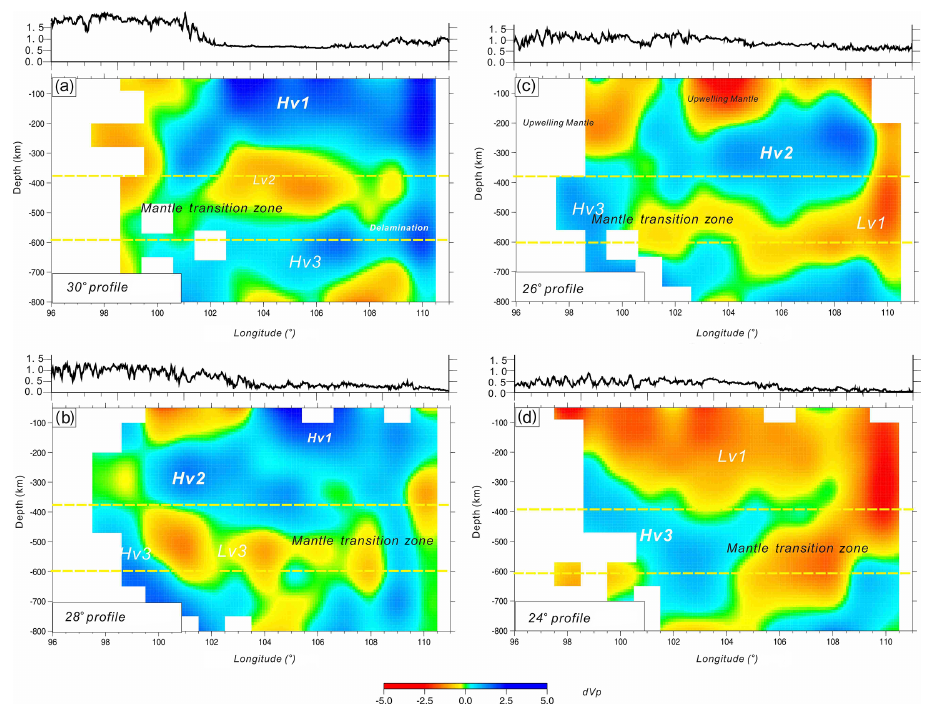
Figure 9. P-wave velocity perturbation profiles along the west–east direction ( a , b , c , and d are at latitudes 24, 26, 28, and 30 ◦ N, respectively) (see Fig. 1 for profile location). Portions of the model where the recovery of the starting model in the CRT was below 20% are not shown (see Fig. 6).